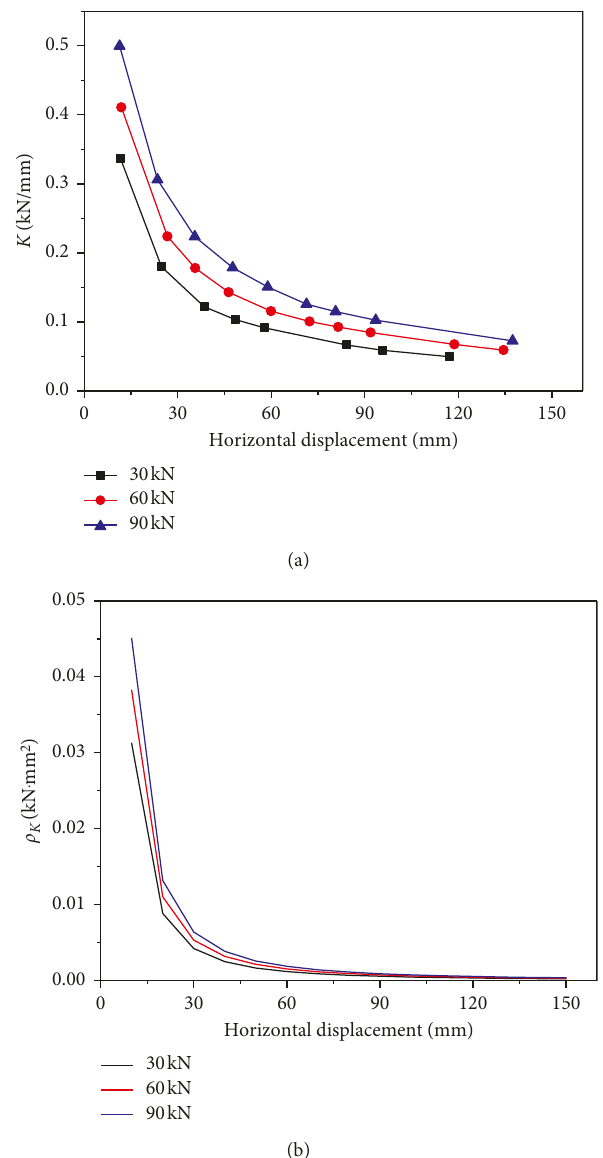
Figure 10: Stiffness change curves. (a) Stiffness degradation curves; (b) stiffness degradation rate